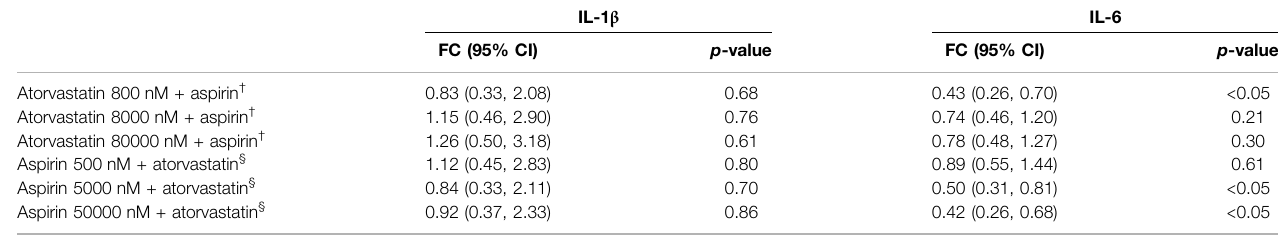
TABLE 1| Estimated foldchangestosecretome fromstroke patientderived Moafter exposure tocombination ofatorvastatinand Aspirin withrespect toavehicle control of atorvastatin 0 + Aspirin 0 nM. Combination of atorvastatin and Aspirin increases the IL-1RA secretions from stroke patients Mo at all dose combinations after 24 h of exposure. Signi fi cance is shown by p -value < 0.05. FC (cid:2) Fold Change, 95% CI (cid:2) 95% Con fi dence Intervals with lower and upper limits. Stroke patient derived Mo exposed to various dose combinations of atorvastatin and aspirin